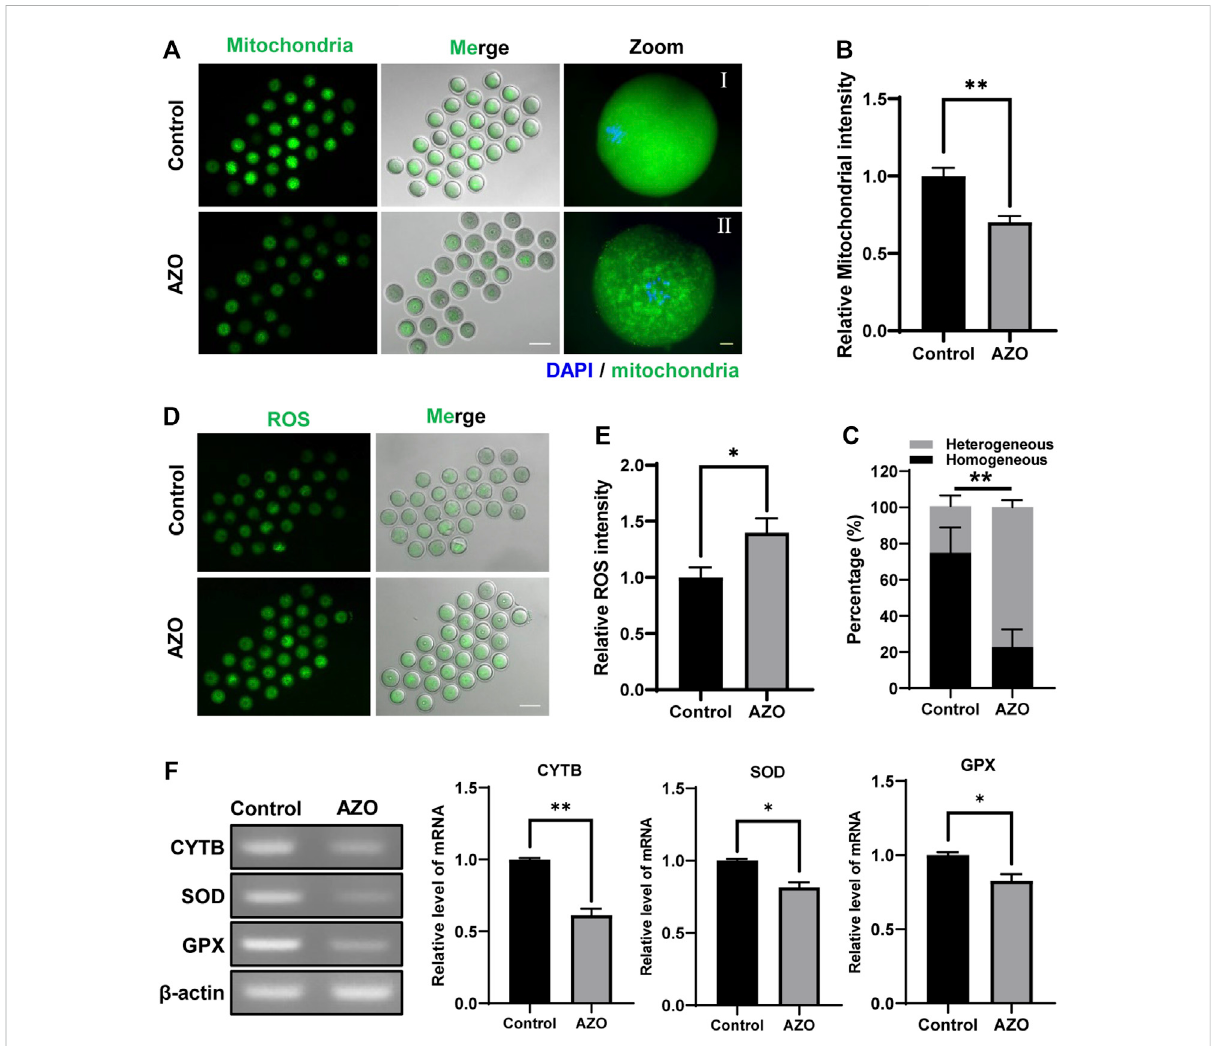
FIGURE 4 AZO impairs mitochondrial distribution and increases ROS levels. Mitochondria were stained with Mitotracker after 8 h of culture with DMSO (Control) or AZO. (A) Representative images of live oocytes stained with Mitotracker. Scale bar, 100 μ m (white). Enlarged images of oocyte with homogeneous distribution in the control group and oocyte with heterogeneous distribution in the AZO group. Scale bar, 10 μ m (yellow). (B) Mitochondrial intensity of oocytes in control and AZO groups is determined. (C) Percentage of oocytes with homogeneous or heterogeneous mitochondrialdistribution. (D) RepresentativeimagesofliveoocytesstainedwithDHR-123.Scalebar,100 μ m. (E) The fl uorescentintensityofROSin control and AZO-treated oocytes. (F) Relative mRNA expression of CYTB, SOD, and GPX in control and AZO-treated oocytes. Data are expressed as mean±SEMfrom fi veindependentexperimentsexcept panel (F) .Datainpanel (F) derivedfromtwoindependentexperiments.* p < 0.05, ** p <